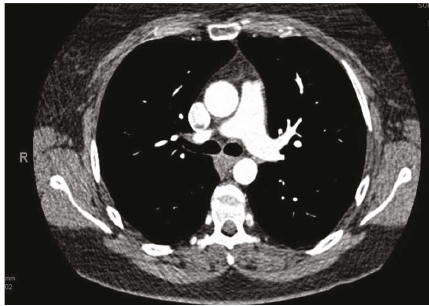
Figure 6: CT obtained for follow-up which reveals resolution of previously noted thrombus of the thoracic